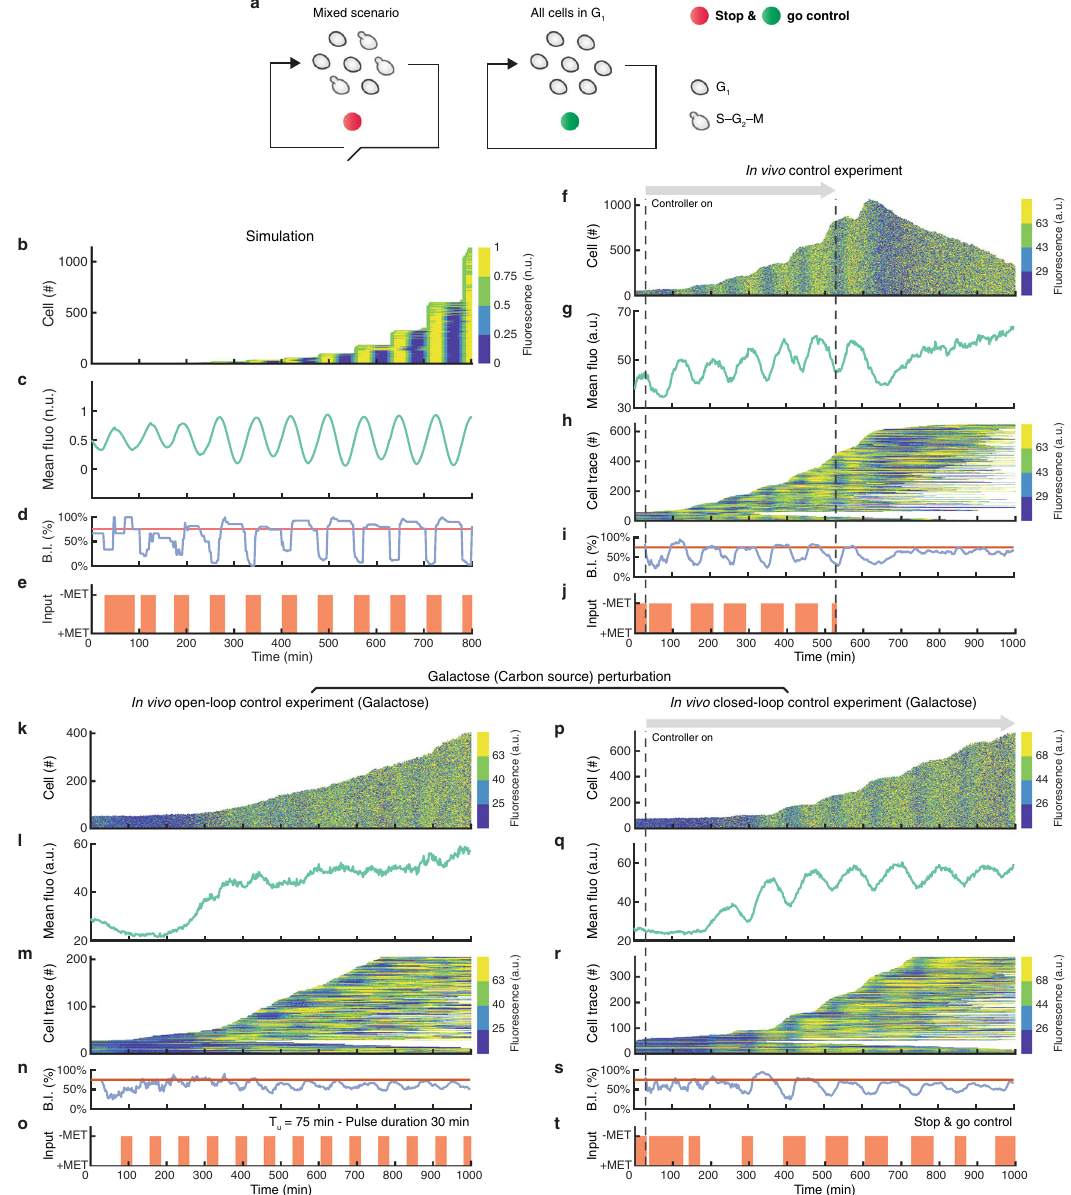
Fig. 3 Automatic feedback control enables cell cycle synchronisation in the non-cycling yeast strain. a Depiction of the stop&go control strategy. The controller waits for cells to stop in the G 1 phase and then restarts their cell cycle by removing methionine from the medium. b – e , Numerical simulation of the stop&go control strategy. f – j , Experimental implementation of the stop&go control strategy. An initial calibration phase of 30 min was required to set up the phase estimation algorithm. Dashed lines indicate the start and the end of the control experiment, after which cells are grown in methionine-rich medium. k – o , Open-loop experiment subjecting cells to alternating pulses of methionine-rich ( + MET) and methionine-depleted ( − MET) medium with a period T u = 75 min using galactose (2% w/v) as carbon source. p – t , Experimental implementation of the stop&go control strategy using galactose (2% w/v) as carbon source. b , f , k , p The number of cells and the distribution of YFP fl uorescence intensity in the population over time. Fluorescence values are binned into 4 colours, corresponding to the quartiles, for clarity of visualisation. c , g , l , q Average YFP fl uorescence intensity in the cell population. h , m , r Single-cell fl uorescence traces over time. Each horizontal line corresponds to one cell. Each line starts when the cell is fi rst detected and ends when the cell exits the fi eld of view. The number of tracked cells does not correspond to the total number of cells as only cells tracked for longer than 300 min are shown. d , i , n , s Budding index (blue) reporting the percentage of cells in the budding phase (S-G 2 -M) computed from the estimated cell cycle phases. The red line denotes the expected value of the budding index in the case of a totally desynchronised cell population. e , j , o , t Growth medium delivered to the cells as a function of time: + MET methionine-rich medium, − MET: methionine-depleted (Supplementary Fig. 7a – e) and in the presence of methionine the fl at pro fi le in the average YFP fl uorescence intensity (Supplementary Fig. 7f – j and Supplementary Movie 5). As (Supplementary Fig. 7b, g) and in the budding index (Supple- expected in both conditions, the number of cells increases mentary Fig. 7d, i), and by quantitative analysis (Supplementary exponentially over time (Supplementary Fig. 7a,f and Supple- Fig. 4b, d, f). Charvin et al. have previously demonstrated that, in mentary Movie 5) while cells are desynchronised as evidenced by this strain, periodic expression of cyclin CLN2 by alternating